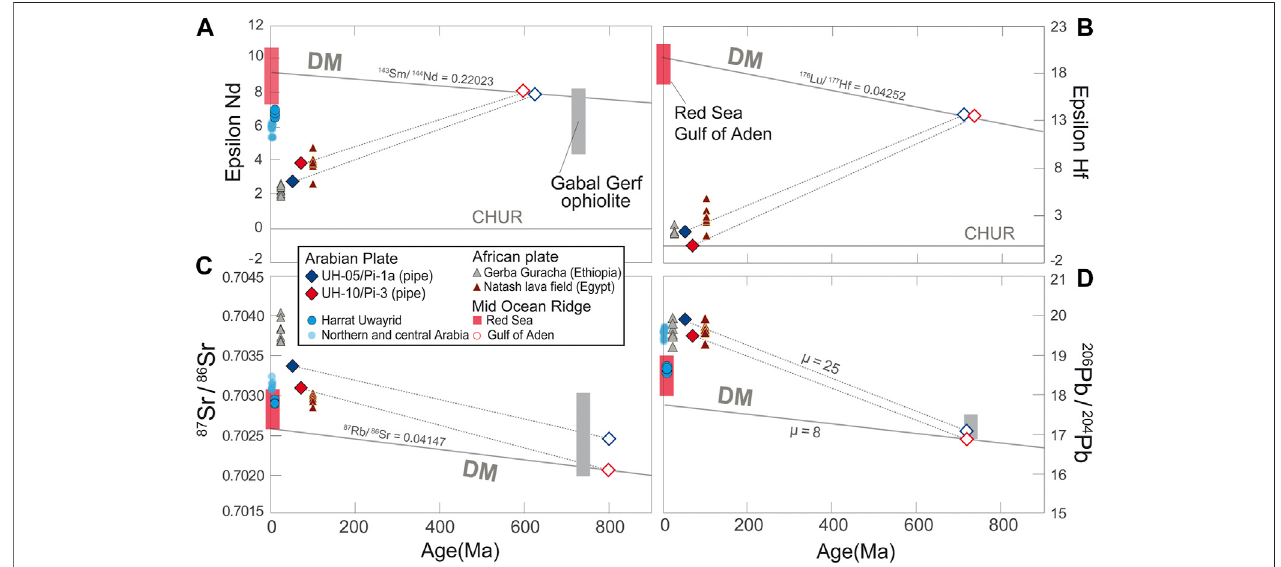
FIGURE10| InitialepsilonNd (A) , epsilon Hf (B) , 87 Sr/ 86 Sr (C) and 206 Pb/ 204 Pb (D) against age (Ma) inalkali basalts from theMarthoumvolcanicpipes (this study) compared to those of other lava fi elds from Central Arabia and present-day MORB from the Red Sea axial trough and Gulf of Aden. The compositions of lava fi elds from East Africa retaining HIMU-like isotopic compositions (from Rooney et al., 2014; Abu El-Rus et al., 2018) and DM from Salters and Stracke (2004) are also reported for comparison. Symbols as in Figure 7 . The grey shaded area indicates the isotopic variability of the Gabal Gerf ophiolite, the largest mantle-derived complex in the Arabian-Nubian Shield (Zimmer et al., 1995; Stein et al., 1997). The temporal evolution of the HIMU-like source of the Marthoum volcanic pipes and DM (calculated for a differentiation time of 3 Ga) also reported based on observed parent/daughter ratios. Note that Nd and Hf of the Marthoum volcanic pipes coherently